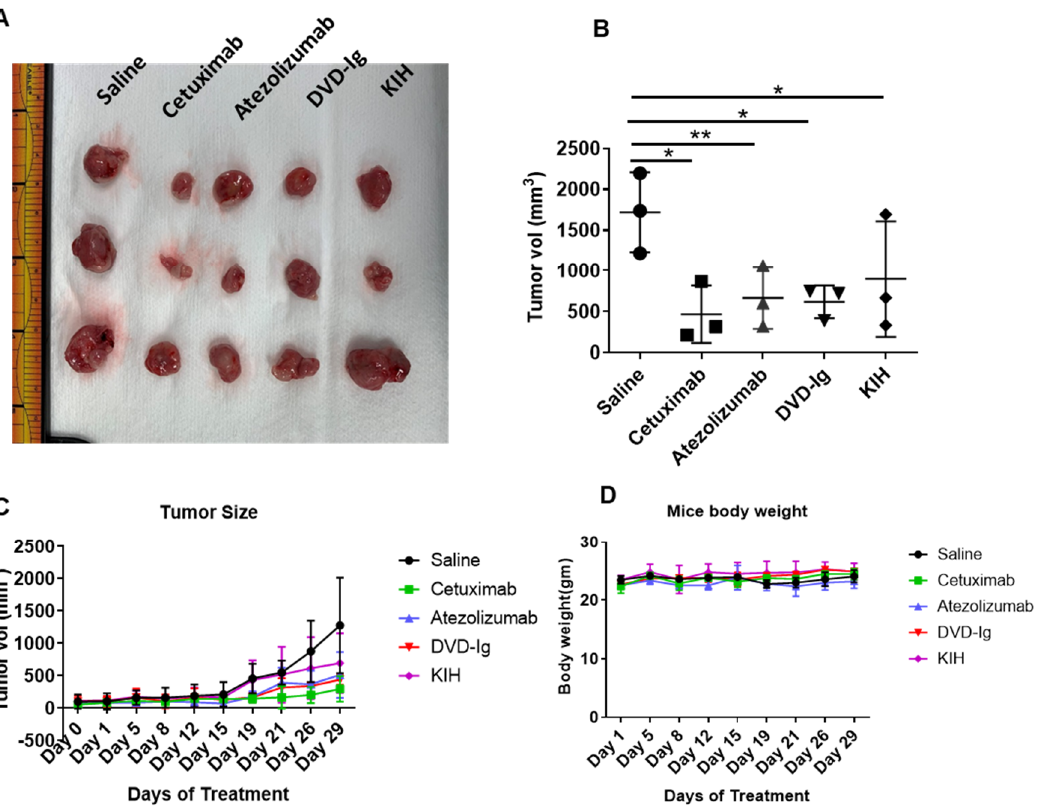
Figure 9. Anti-EGFR/PD-L1 BsAbs exhibited potent antitumor activity in MDA-MB-231 tumor xenograft study. Five million MDA-MB-231 cells were injected in left flank of athymic nude mice. Treatment conditions: saline, ATE, Cetux and anti-EGFR/PD-L1 BsAbs were given intraperitoneally at 10 mg/kg body weight twice a week. ( A ) The images of the excised tumors at the end of the treatments. ( B ) Tumor volume was calculated after removing the tumors from mice at the end of treatment course on day 29; *, p < 0.05; **, p < 0.01. ( C ) Tumor growth curve over the course of treatment. ( D ) Mouse body weights in each treatment group were measured over the course of treatment.